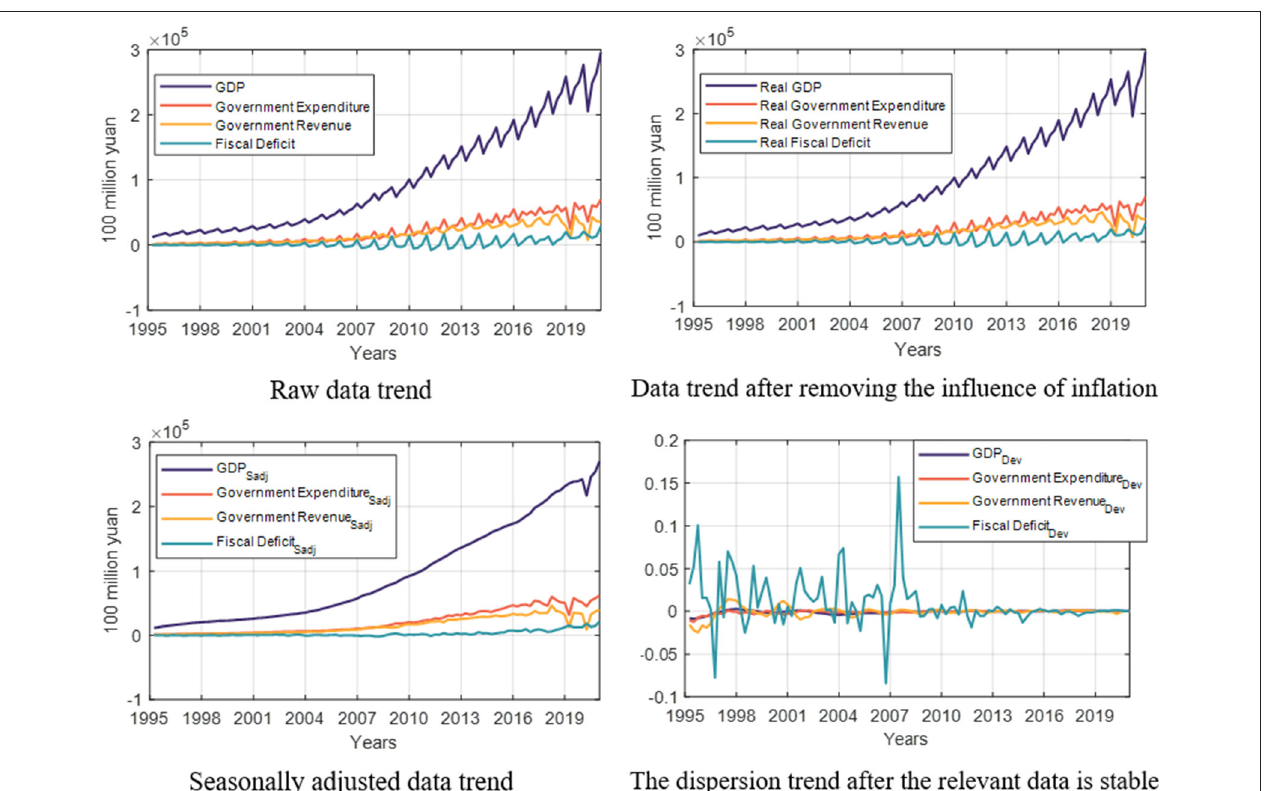
FIGURE 1 | Related data trend